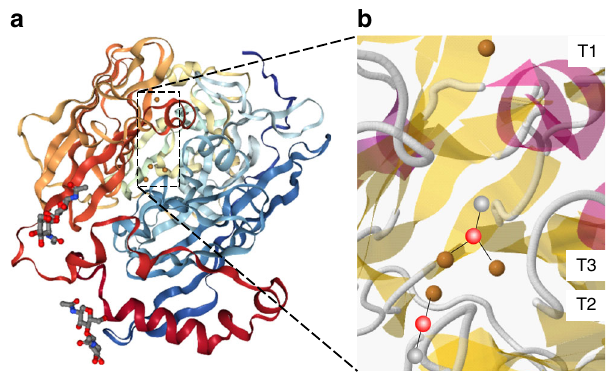
Fig. 1 Structure of Mv BOD. a Representation of the crystal structure (PDB: 2XLL); b Zoom at the four Cu ions within Mv BOD in its resting oxidized state with the hydroxide bound to T3 and